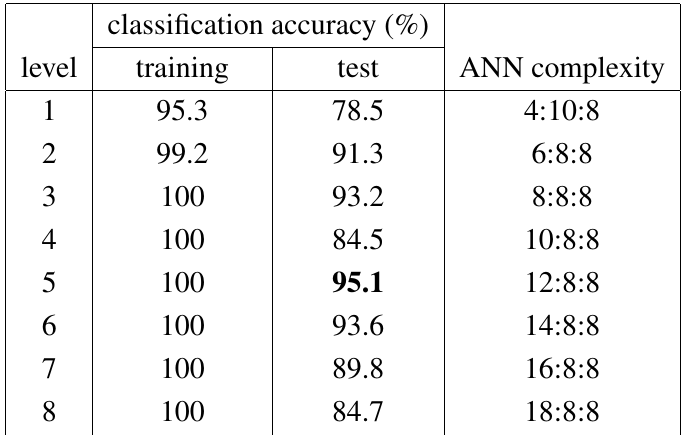
Table 2. Motion classification accuracy with the training and test data, and ANN complexity when only the normalized variances of DWT decomposition coefficients are used as